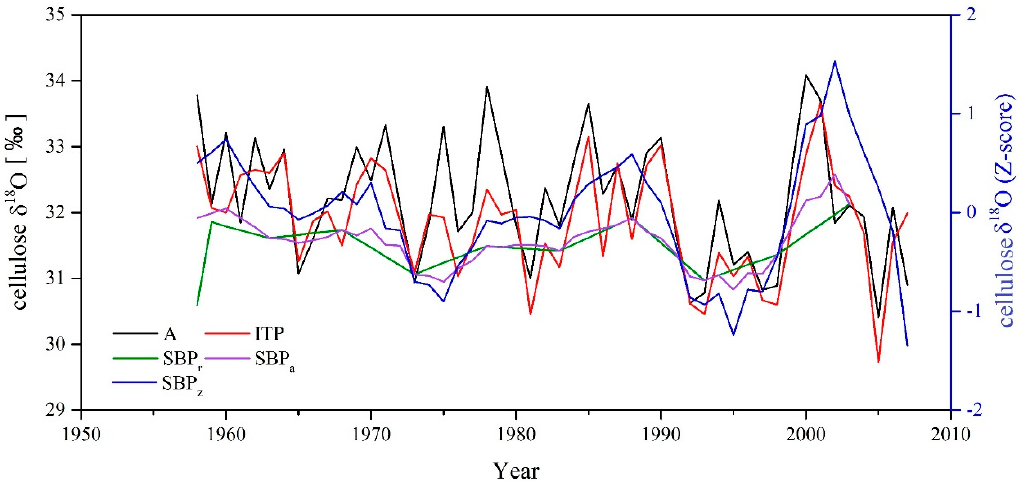
Figure 5. Comparison of the inter-annual δ 18 O variations of different versions of oxygen stable isotope chronologies of J. polycarpus from 1958 to 2007, including the annually resolved chronology established from individual analyses (A); the inter-tree pooled chronology (ITP) and the shifted 5-year block serial pooled chronologies (SBP a , SBP r , SBP z ). The scale of the blue vertical axis reflects the values of the SBP z series.